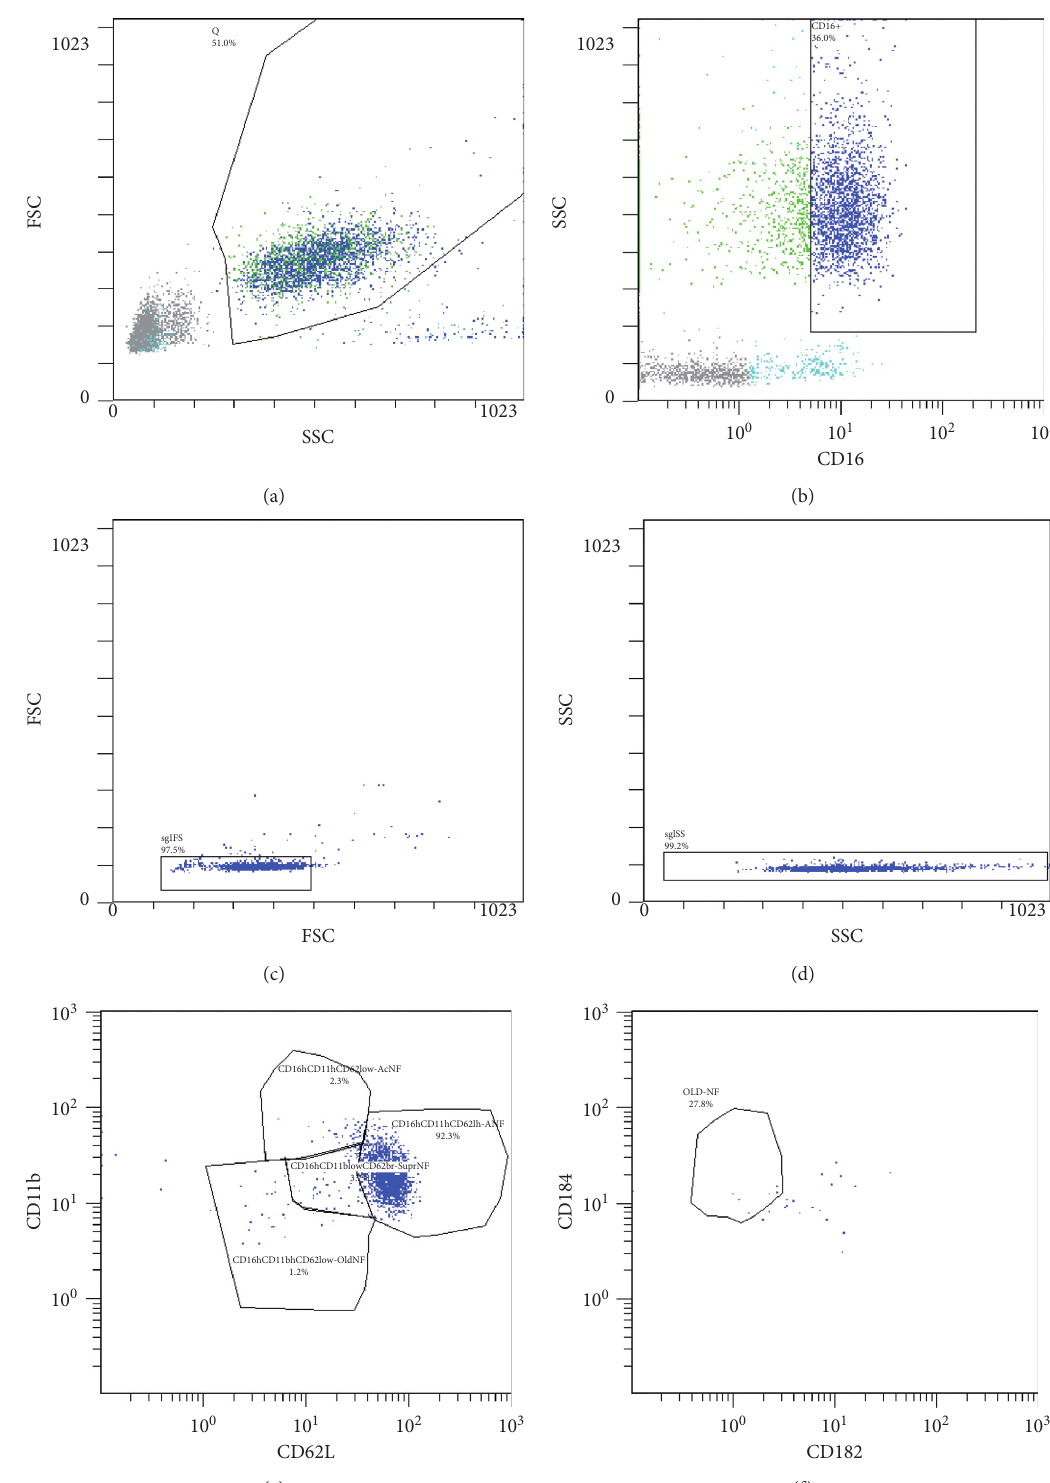
Figure 1: Gating strategy of flow cytometry. Sequential gating strategy for the identification of neutrophil subpopulations. Granulocytes were gated based on FSC and SSC ( a ). Furthermore, CD16 + cells were identified and single cells were gated (c–d). Identification of neutrophil subpopulations depending on CD11b and CD62 L expression (e). Identification of ageing neutrophils by the expression of CD184 and CD182